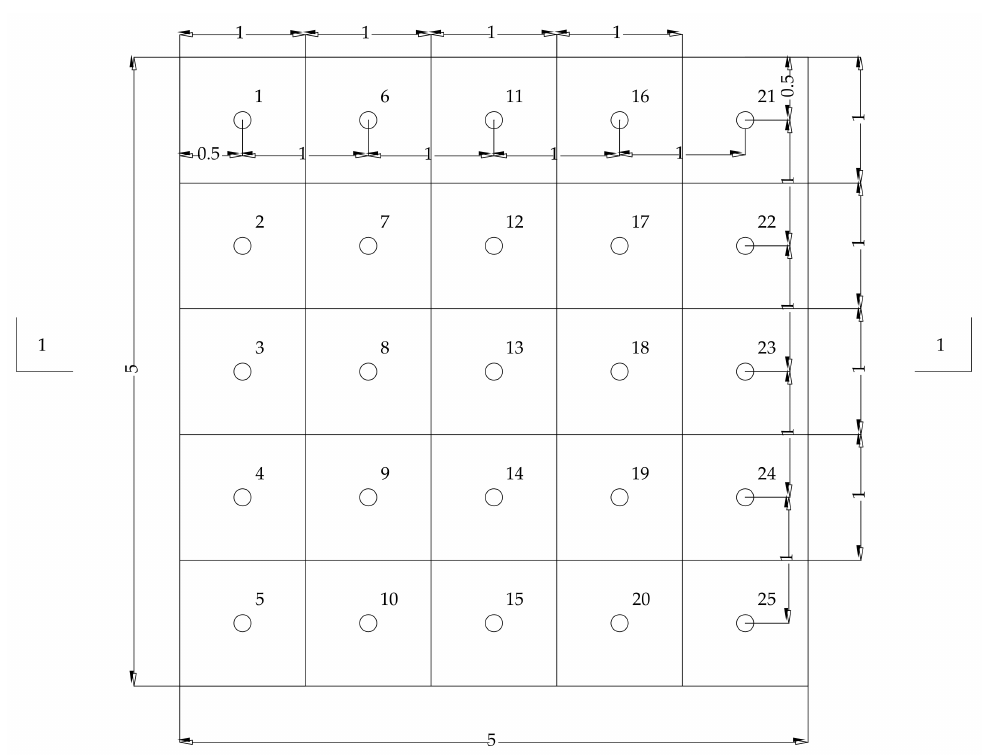
Figure 6. The horizontal distribution diagram of the experimental test points.